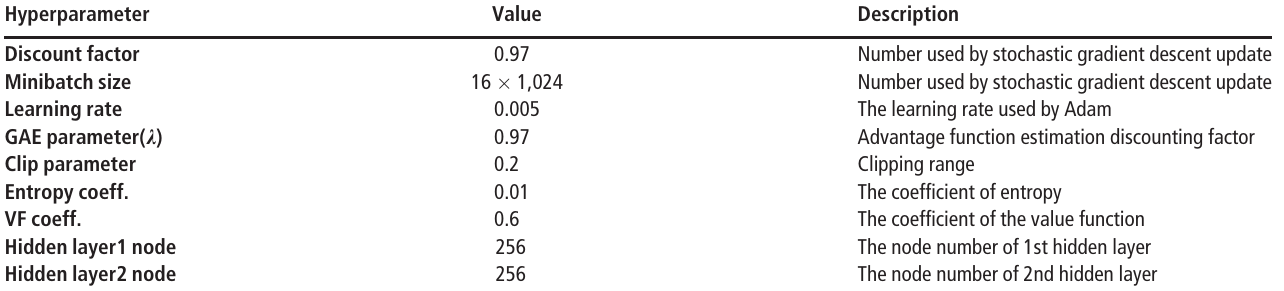
Table 1 Hyperparameters of H-PPO Hyperparameter